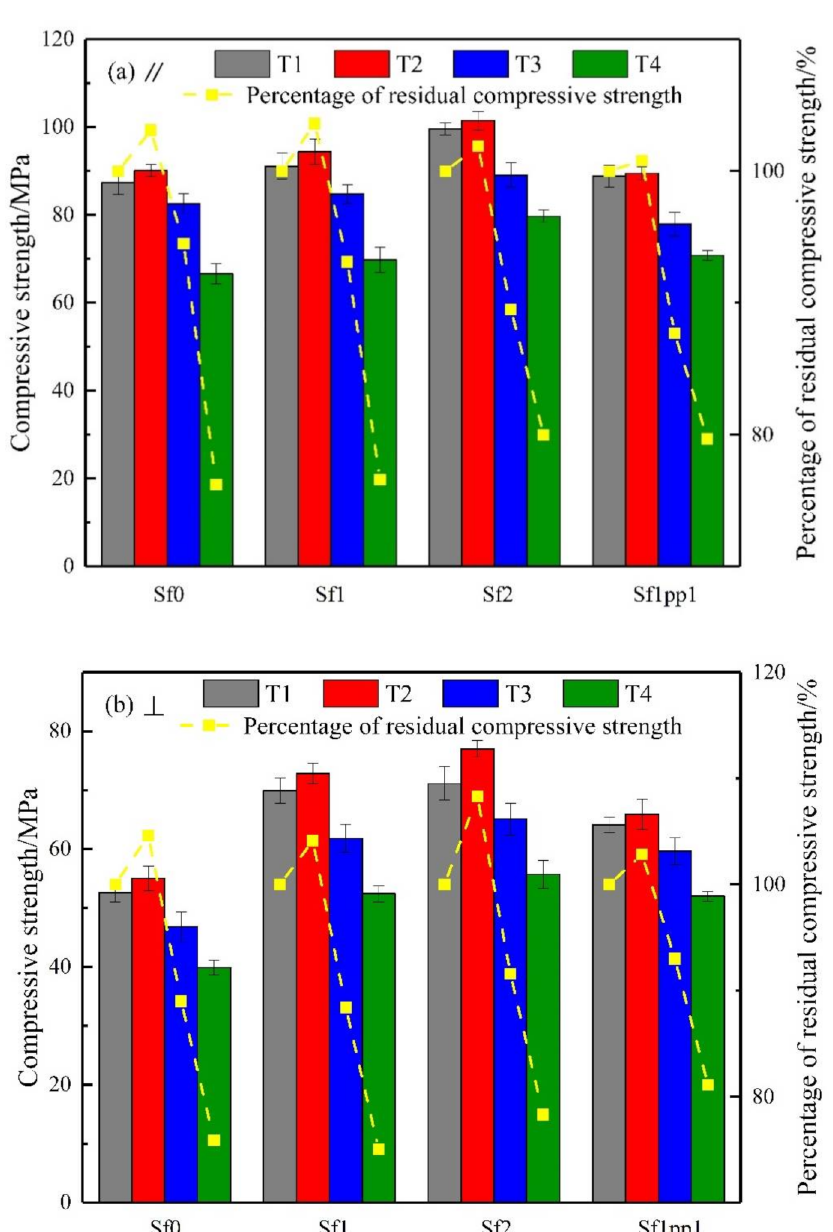
Figure 4. Evolution and residual percentage of compressive strength of the repaired systems under high temperatures: stress direction ( a ) (cid:107) , ( b ) ⊥